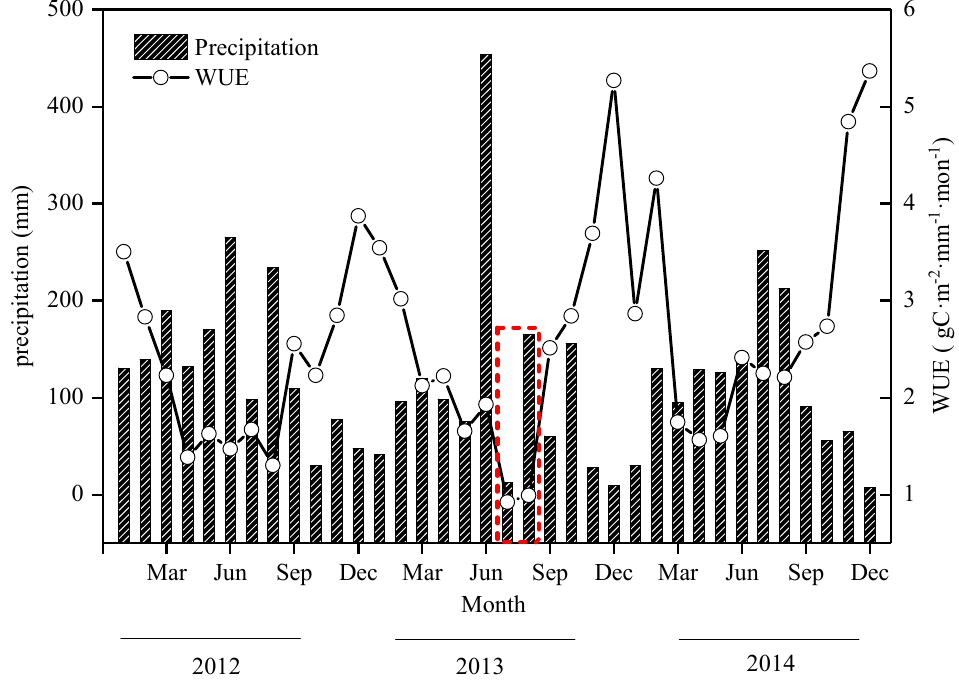
Figure 3. The monthly dynamics of water-use efficiency (WUE, gC · m -2 · mm -1 · mon -1 ) and Precipitation in the Moso bamboo forest in Anji country from 2012–2014. The red, dotted frame represents the monthly variation in WUE during the flash-drought period.